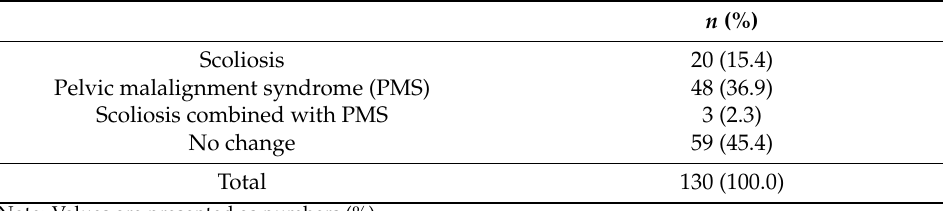
Table 2. Changes in the spine and pelvic alignment after more than 2 years of follow-up among 130 children.